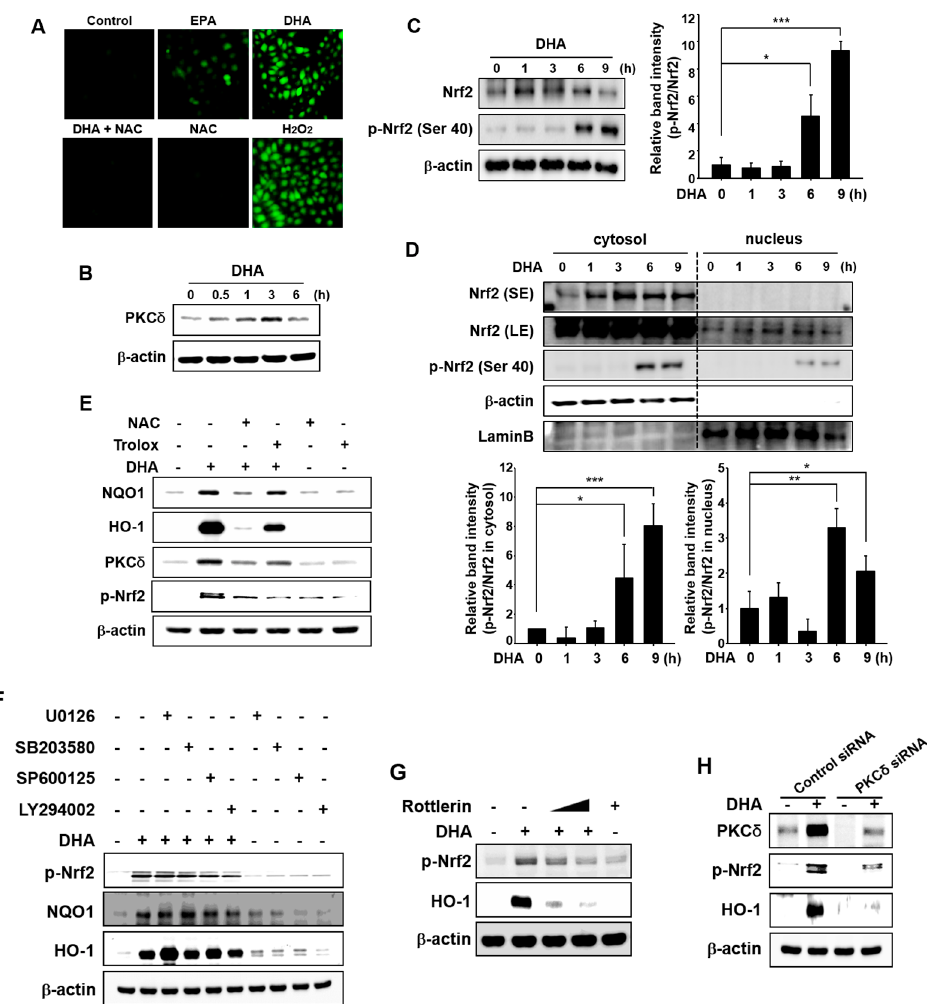
Figure 5. Role of ROS in DHA-induced Nrf2 activation mediated by PKC δ . ( A ) MCF-10A cells were treated with each indicated drug (EPA and DHA; 25 µ M, NAC; 5 mM, H 2 O 2 ; 100 µ M) or in proper combination for 3 h and then examined for the intracellular accumulation of ROS under the confocal microscope after DCF-DA fluorescence staining. ( B ) Cells were treated with DHA (25 µ M) for the indicated time periods, and the effect of DHA on PKC δ activation was determined by Western blot analysis. ( C ) MCF-10A cells treated with DHA (25 µ M) were harvested at the indicated time intervals. The effect of DHA on the phosphorylation of Ser 40 at Nrf2 was assessed by Western blot analysis. Each blot is a representative of three different experiments. Columns, means ( n = 3); bars, SD. * p < 0.05 or *** p < 0.001. ( D ) Nuclear and cytosol extracts were prepared at the indicated intervals after incubation with DHA (25 µ M). Each blot is a representative of three different experiments. Columns, means (n = 3); bars, SD. * p < 0.05 or ** p < 0.01 or *** p < 0.001. SE: short exposure, LE: long exposure. ( E ) Cells were pretreated with NAC (5 mM) or Trolox (100 µ M) for 1 h, then incubated with DHA (25 µ M) for another 3 h (for PKC δ ), 6 h (for p-Nrf2) or 9 h (for HO-1 and NQO1). ( F ) Cells were pretreated with U0126, SB203580, SP600125, or LY294002 (25 µ M) for 1 h, followed by incubation with DHA (25 µ M) for additional 6 h (for p-Nrf2) or 18 h (for HO-1 and NQO1). ( G ) Cells were pretreated with rottlerin (1 or 10 µ M) for 1 h, and then incubated with DHA (25 µ M) for additional 3 h. ( H ) MCF-10A cells were treated with DHA (25 µ M) for 6 h after transfection with siRNA control or siRNA PKC δ for 24 h. Activation of signal transducing kinases including mitogen-activated protein kinases (MAPKs), phosphoinositide 3-kinase (PI3K)/Akt, and PKC has been reported to induce nuclear